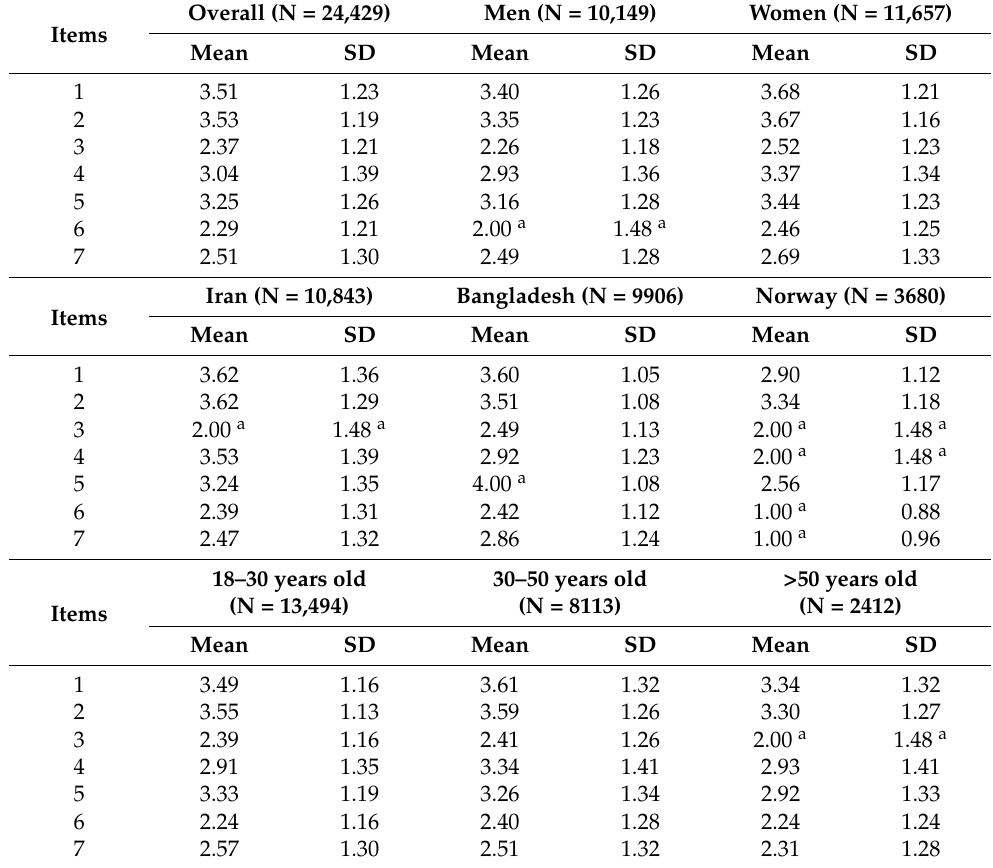
Table 1. Descriptive statistics of the